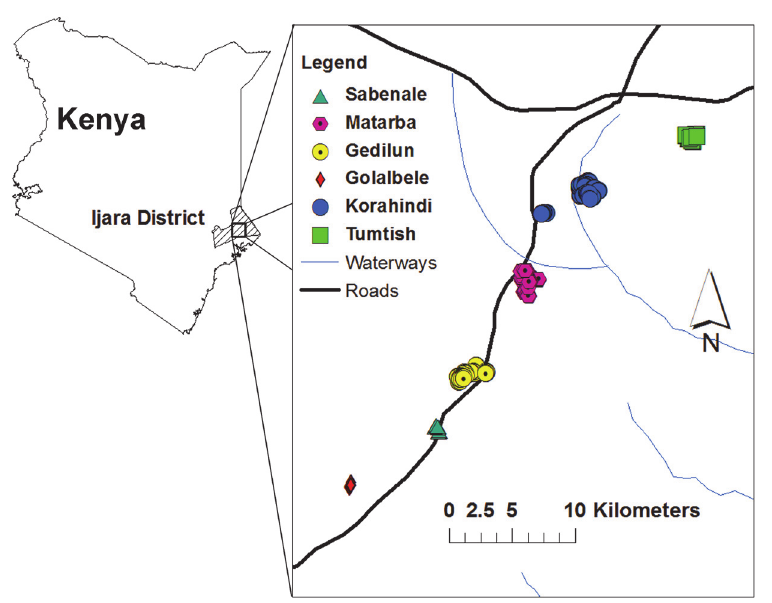
Fig 1. Map of the study area in Northeastern Province, Kenya. Shown are the locations of the Ijara District and, in the inset, the relative locations of the participating study villages in the Sangailu area of